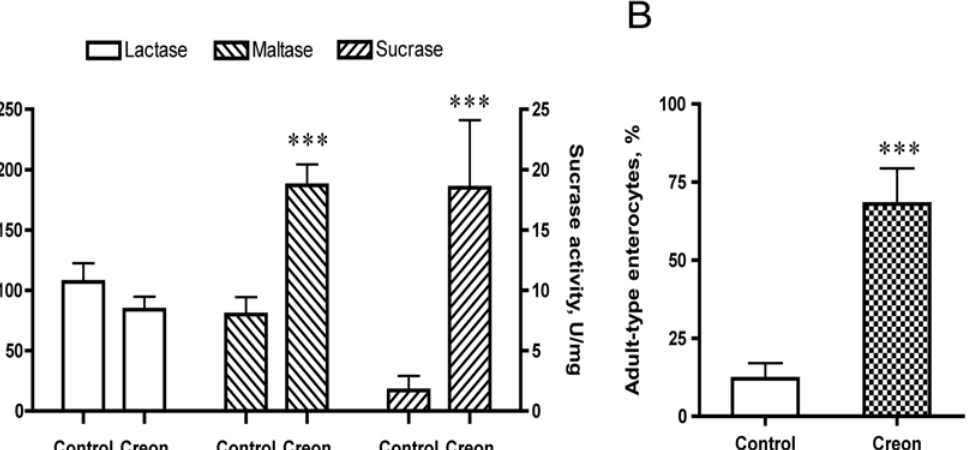
Fig 1. Intestinal disaccharidase activities, i . e ., lactase, maltase and sucrase (U/mg protein), in the proximal small intestine (A), and the portion of adult-type enterocytes, lacking supra-nuclear vacuoles, appearing on the villi in the distal small intestine (B) after gavage feeding the pancreatic enzyme preparation, Creon, or α -lactalbumin (control) during 14 – 16 days of age in 17 d-old suckling rats. Statistically significant differences between control and enzyme-treated groups (mean ± SD, n = 10 – 11) are indicated by *** P < 0.001.